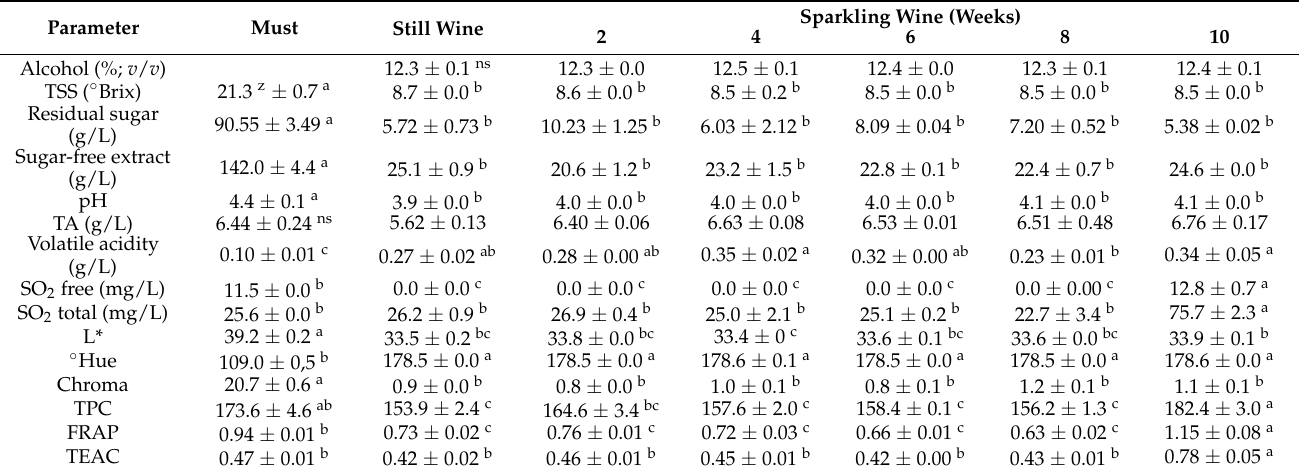
Table 3. Physico-chemical parameters of enriched must, still wine, and during the sparkling process of melon-based wine (10 weeks).